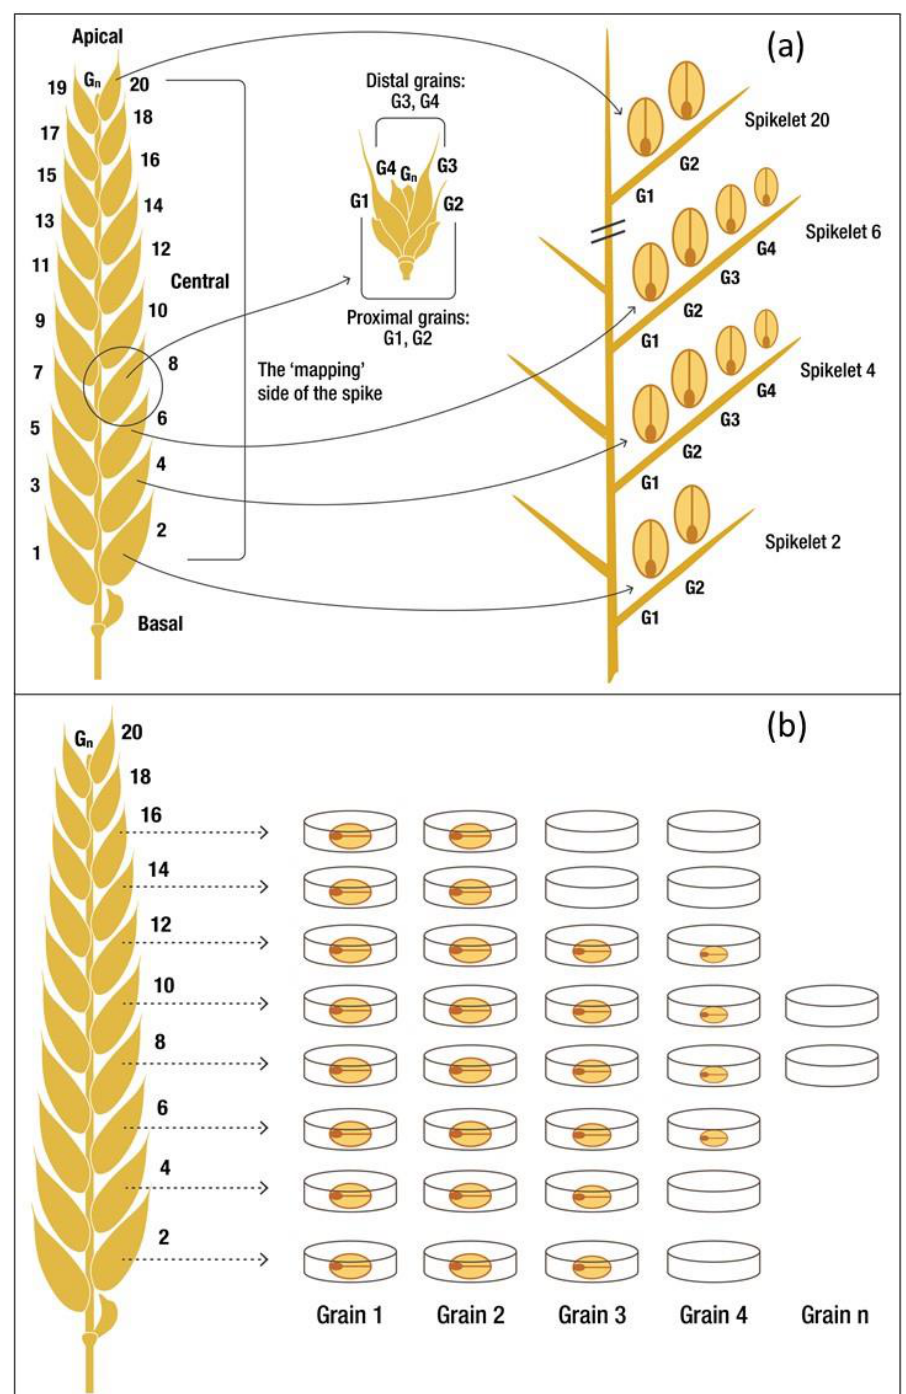
Figure 3. ( a ) A schematic diagram showing grain positions (G1, G2 – proximal, G3 and G4 – distal) at different spikelet positions. Spikelet 1 (S1) is the most basal, through spikelet position 20 (S20) is the most apical. ( b ) A schematic diagram showing the technique of grain mapping. Grains are individually removed from each spikelet and placed into their respective dish labelled with both the spikelet (Spikelet 2 to n) and floret (grain number from G1 to Gn). At anthesis, 25 cm of crop row from each of the four inner plot rows was hand − cut above ground level using a quadrat (0.254 m 2 ) [37]. These biomass cuts were dried at 70 °C for 48 h and weighed. Anthesis cuts were not taken in 2018 Heater+ plots as the removal